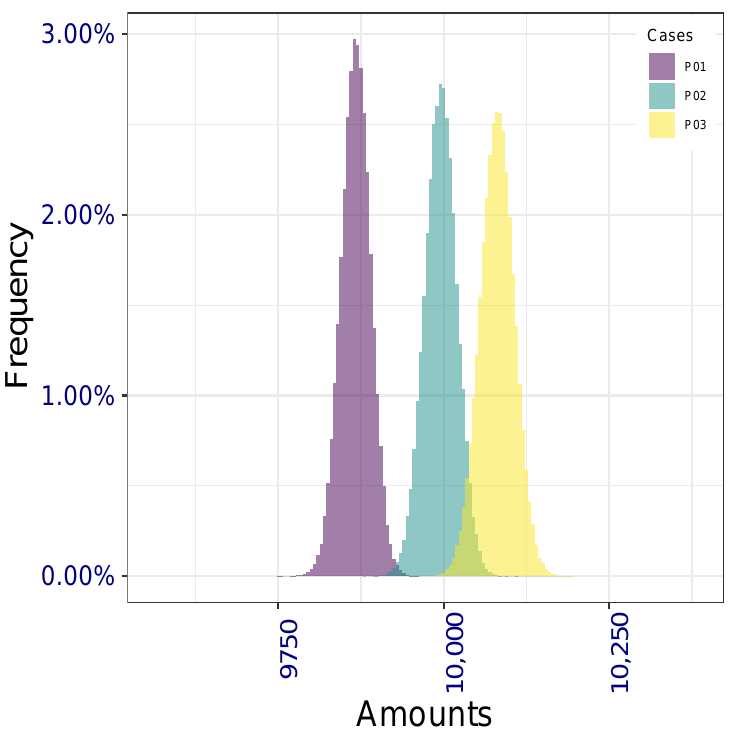
Figure 6. Impact of cannibalization effect: empirical distributions of the annual benefit payout at time t =